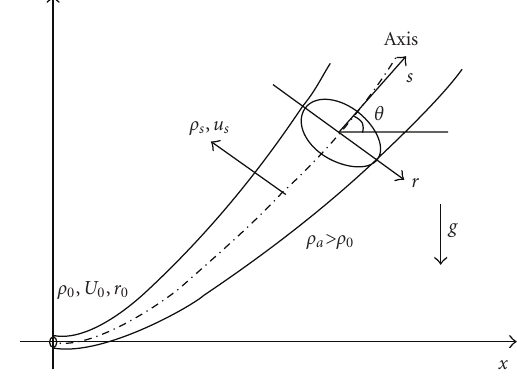
Figure 1: Definition diagram for horizontal buoyant jet discharges from round orifice into the unstratified